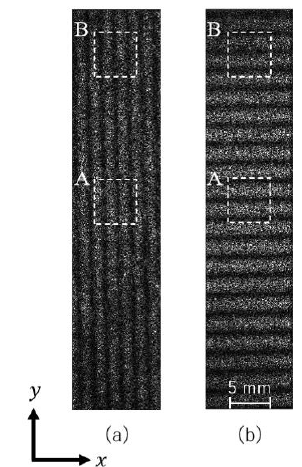
Figure 7. Carrier fringe image: ( a ) x-direction; ( b ) y-direction.